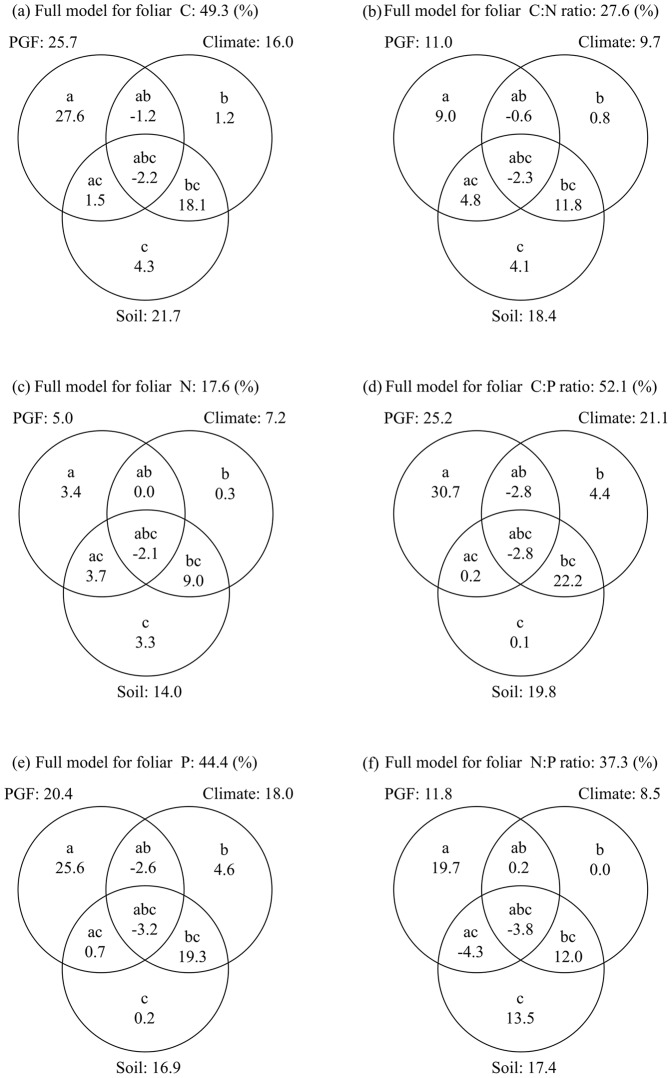
Variation partitioning (R2, %) of PGF, climate and soil in accounting for the variations in leaf C, N, P and C∶N∶P ratios.
a, b, and c denote the independent effect of plant growth form (PGF), climate and soil, respectively; ab, ac, and bc are the interactive effect between PGF and climate, PGF and soil, climate and soil, respectively; abc denotes the interactive effect among the three factors.